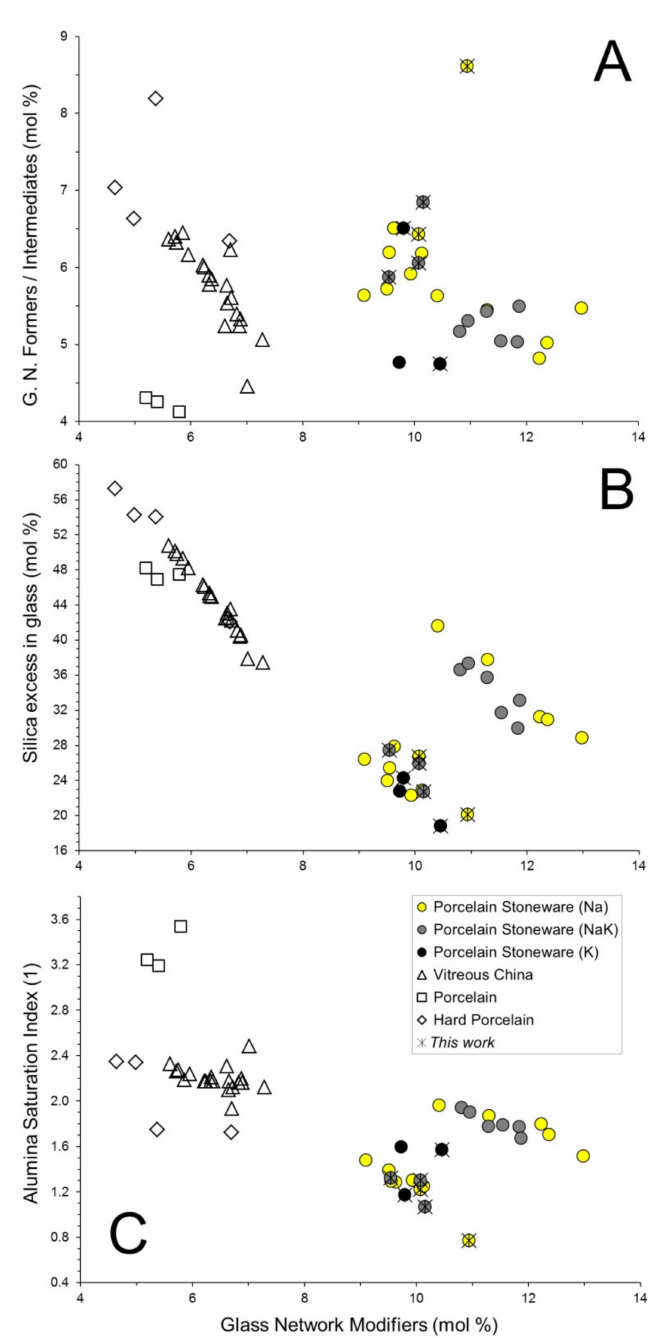
Figure 4. Chemical composition of the vitreous phase in porcelain stoneware bodies compared to other porcelain-like materials. Glass Network Modifiers (MgO + CaO + Na 2 O + K 2 O) versus ( A ) the ratio of Glass Network Formers (SiO 2 ) to Intermediates (TiO 2 + Al 2 O 3 + Fe 2 O 3 + ZrO 2 ); ( B ) silica in excess with respect to a feldspathic melt; ( C ) Alumina Saturation index calculated on mol % (Al 2 O 3 /CaO + Na 2 O + K 2